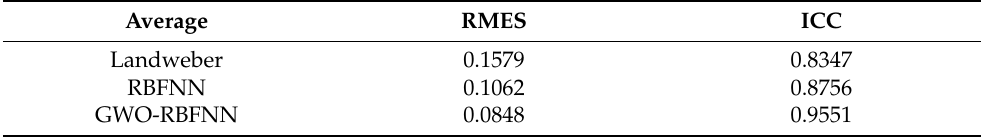
Figure 6. Typical models from the noise-free test set and their reconstructed images with different algorithms. Table 1. Averages of RMSE and ICC in the noiseless test